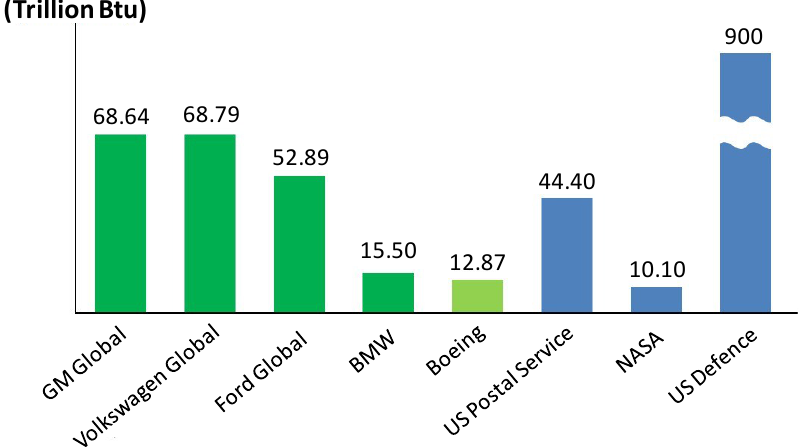
Figure 2. Energy consumption in auto manufacturing industries in